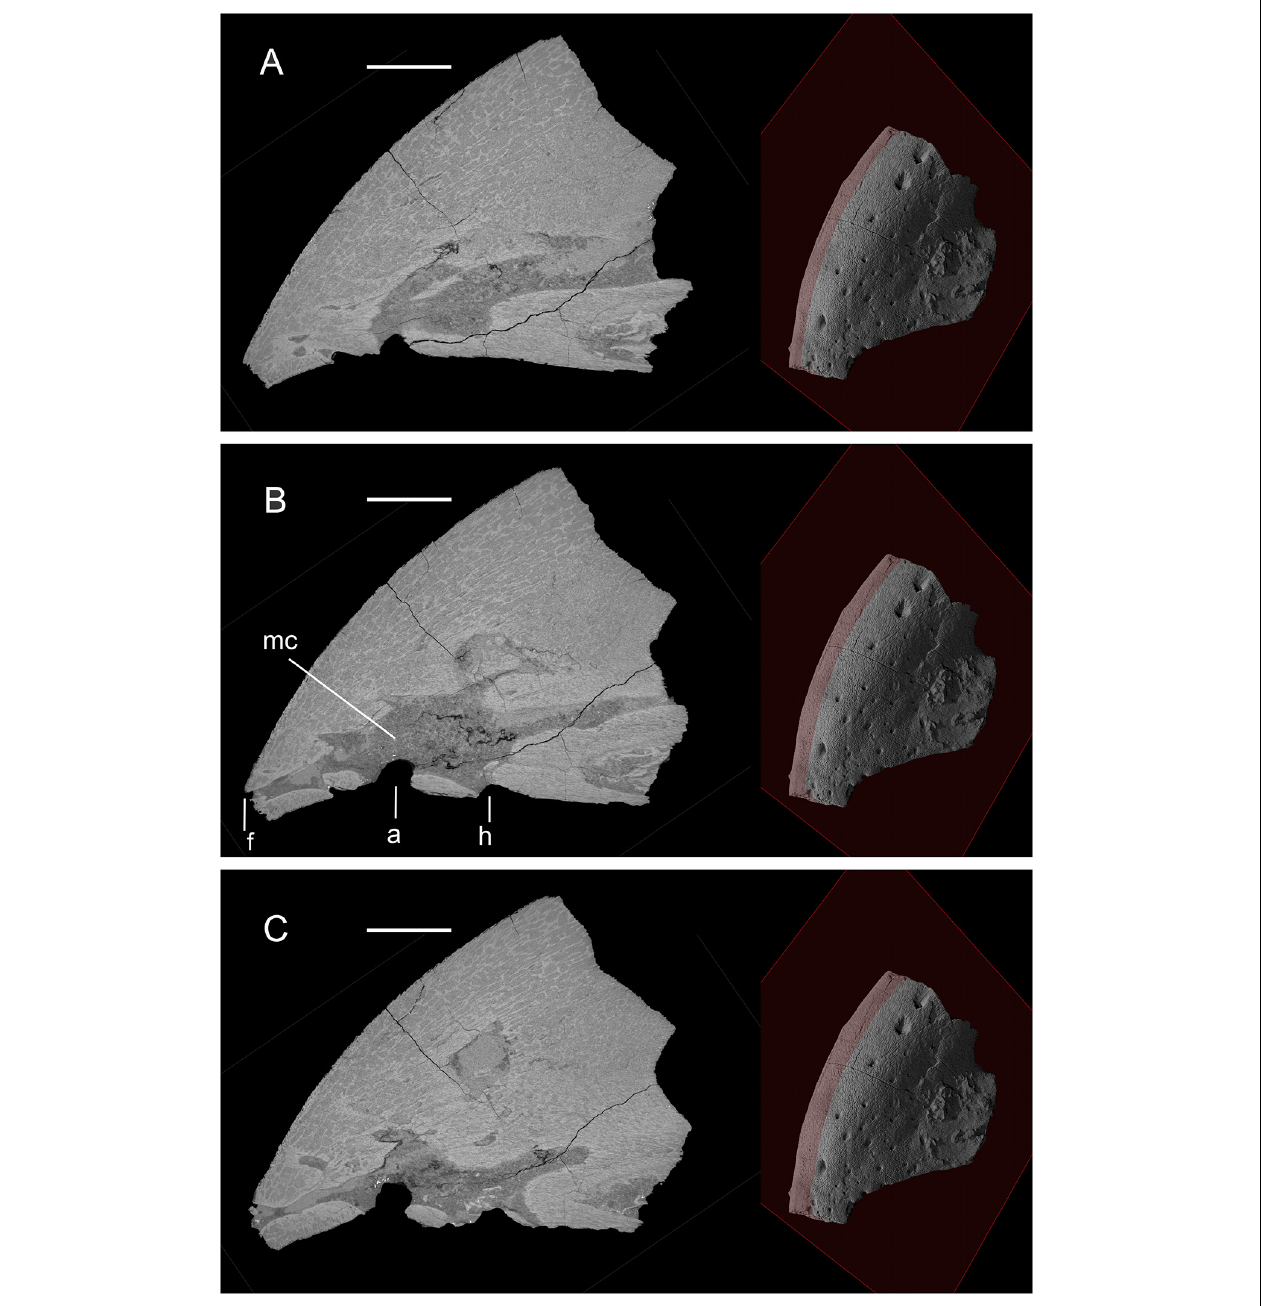
FIGURE 2 | Three parasagittal sections through the premaxilla of YPM 13106, showing communications between canals and with the medullary cavity. Plane of parasagittal section moves toward the left from (A) through (B) and (C) . The position of the plane is shown to the right of each section. Two of the large ventral pits (a, h) (see Figure 1 ) appear to communicate with the medullary cavity (mc), and a dorsal distal foramen (f). Scale bars, 10